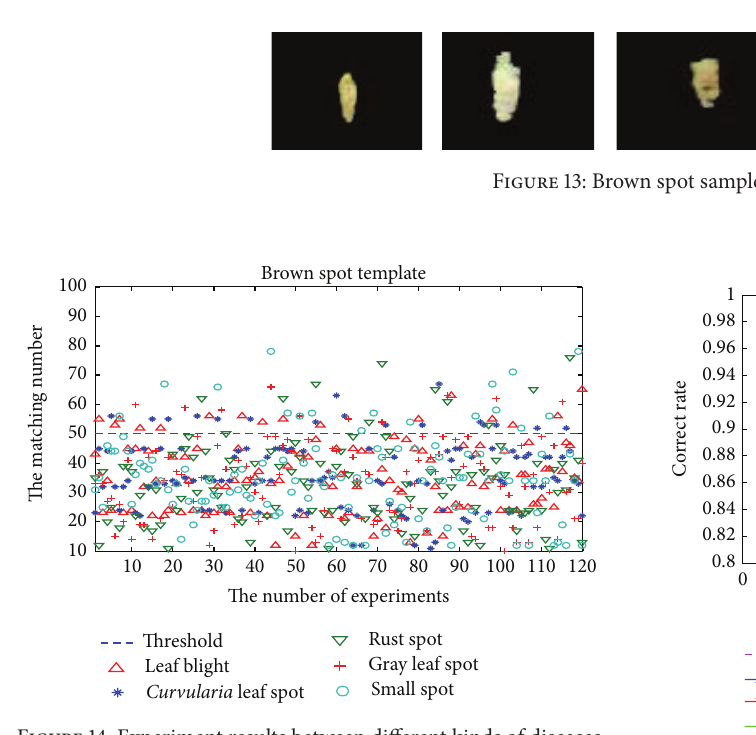
Figure 14: Experiment results between different kinds of diseases.